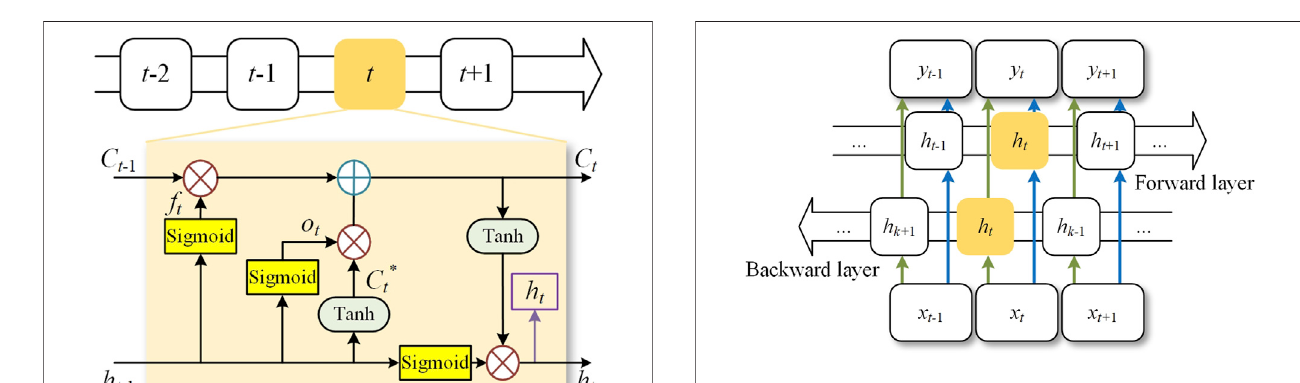
FIGURE 5 | Structure of the Bi-LSTM